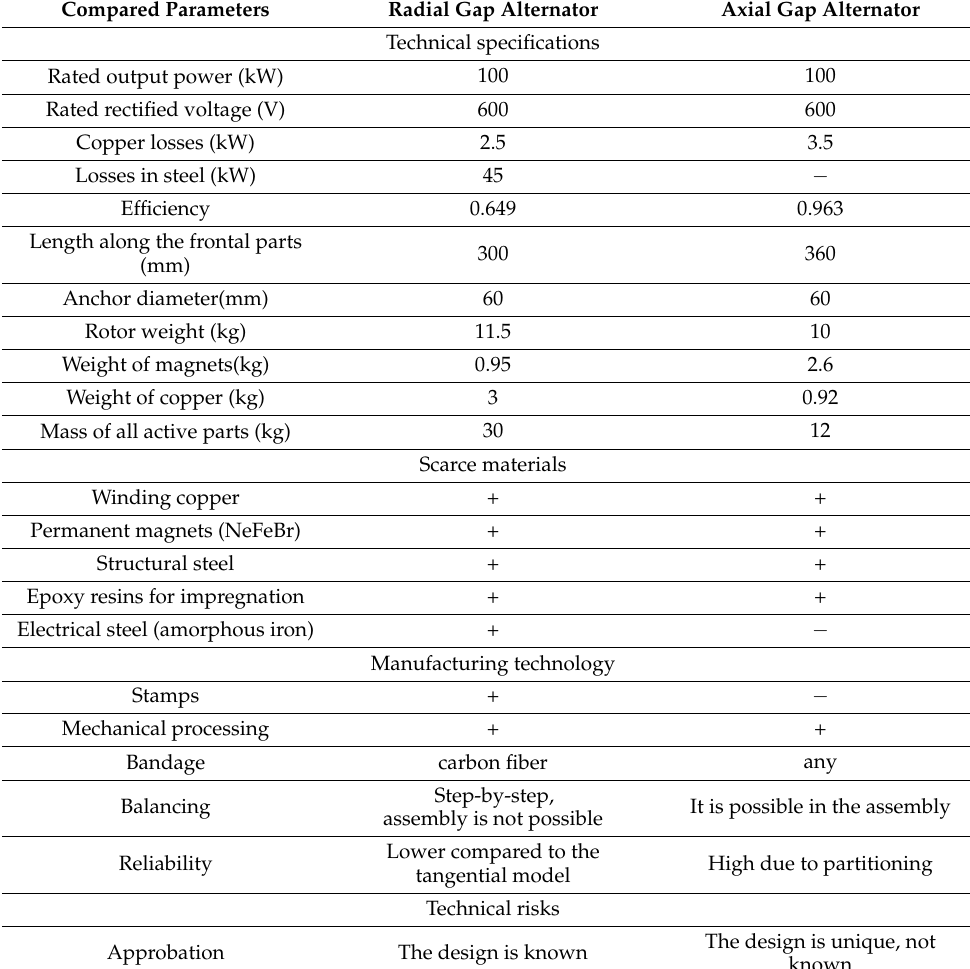
Table 2. Comparative analysis of design